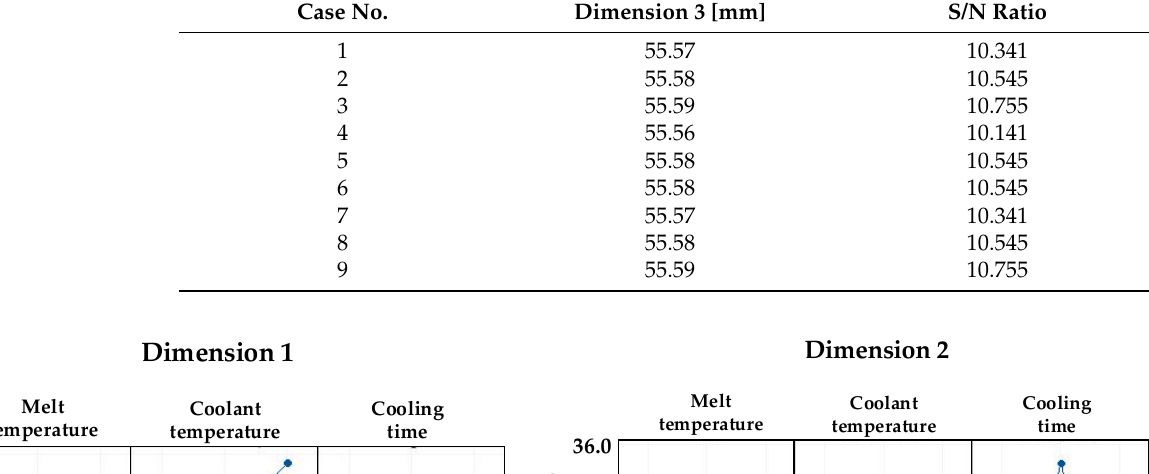
Table 15. S/N ratio of measurement 3 for pivot sub-assembly. Case No.